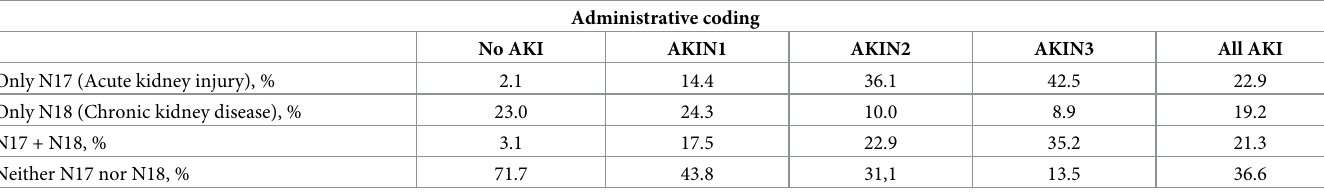
Table 4. Comparison of the administrative coding among the AKI